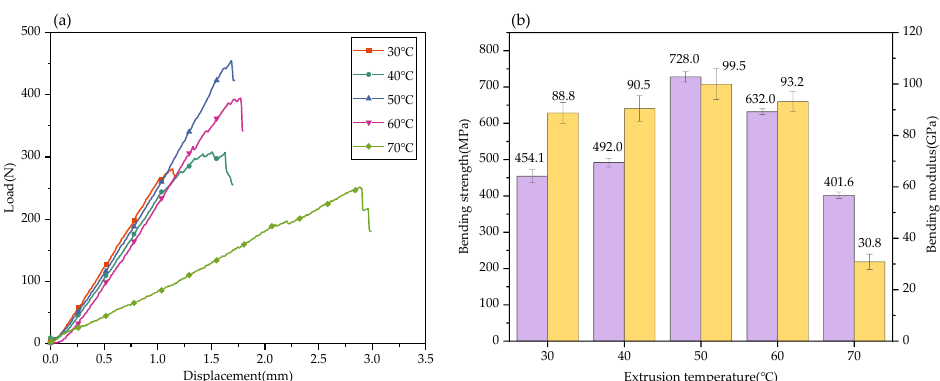
Figure 8. Three-point bending test results of GO-CF/EP composites ( a ) load – displacement curve, ( b ) bending strength and bending modulus.